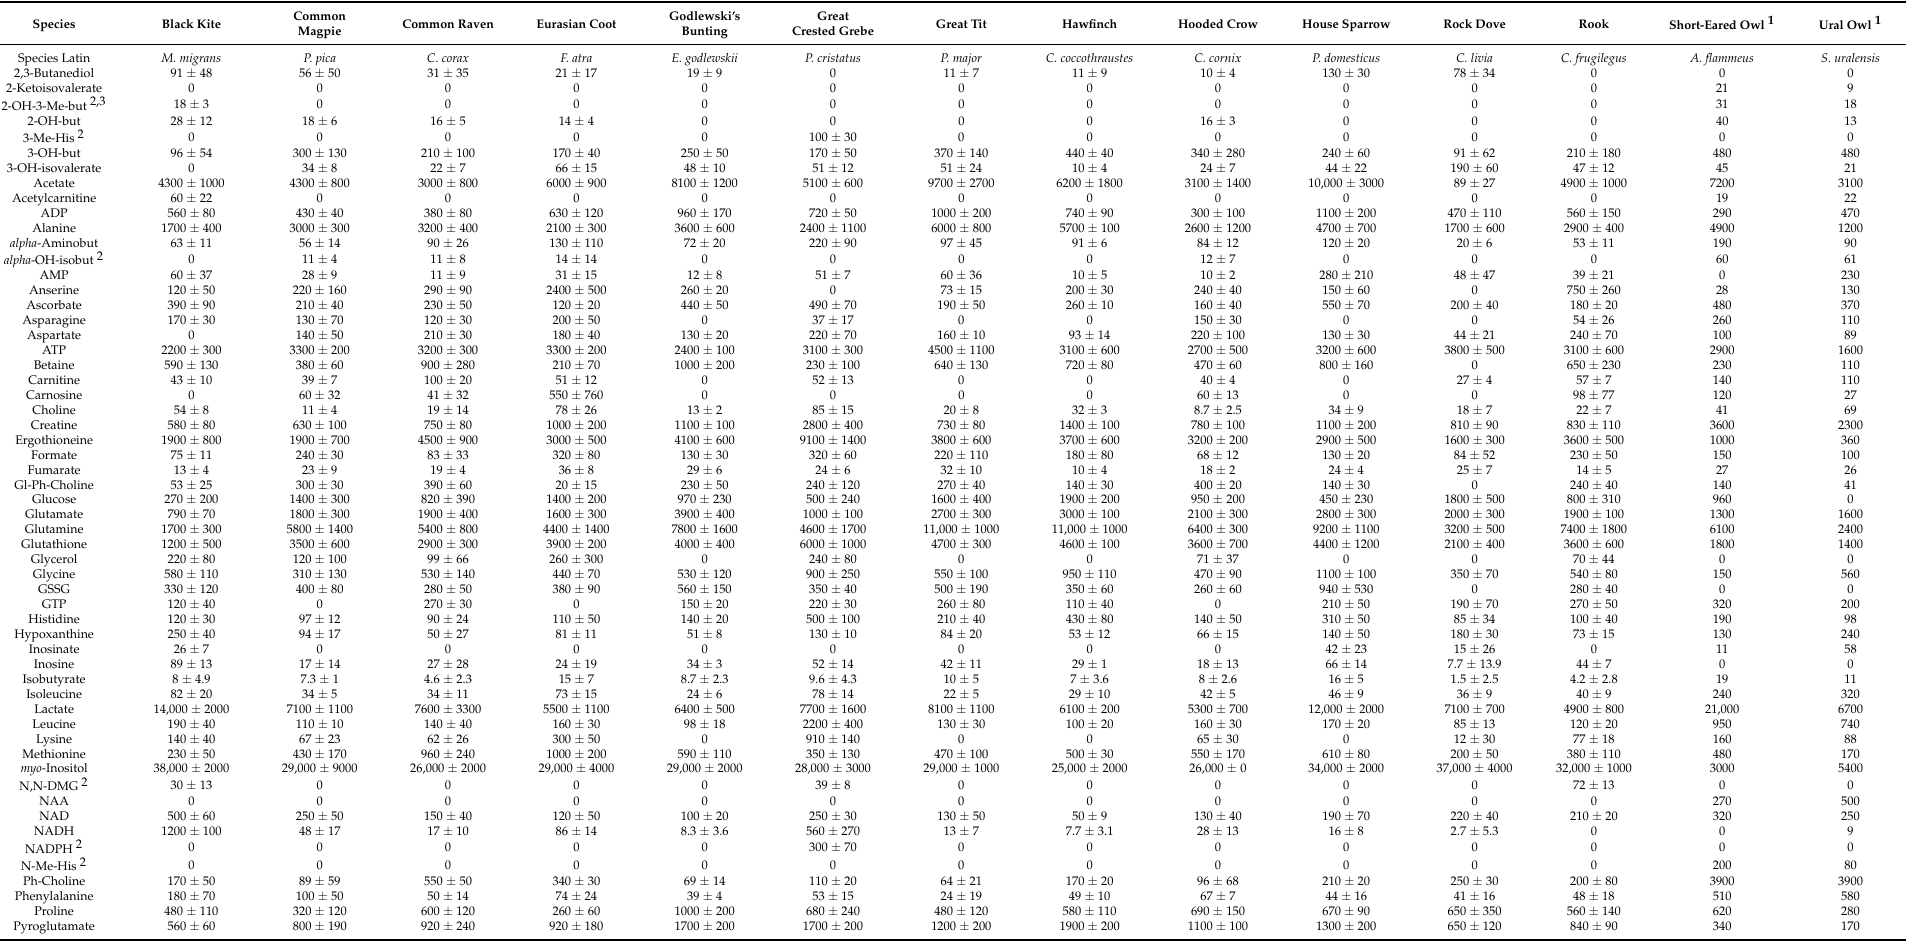
Table 2. Mean concentrations of metabolites in the lenses of 14 bird species. Values are given in nmoles per gram of the tissue wet weight (nmol/g, mean ±